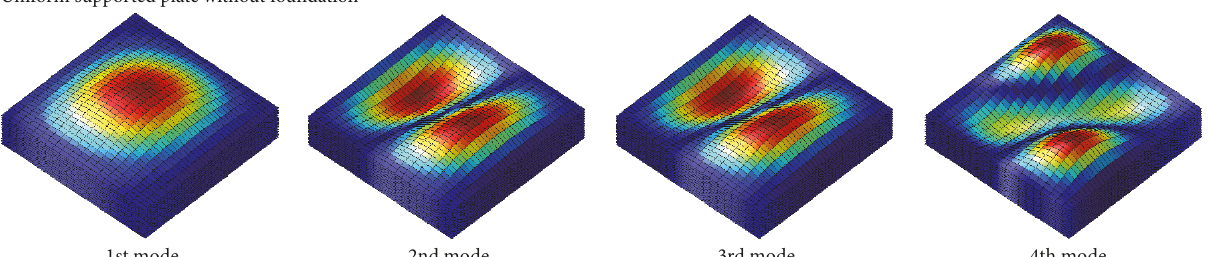
Figure 12: Mode shapes of multipoints supported laminated plate on the Pasternak